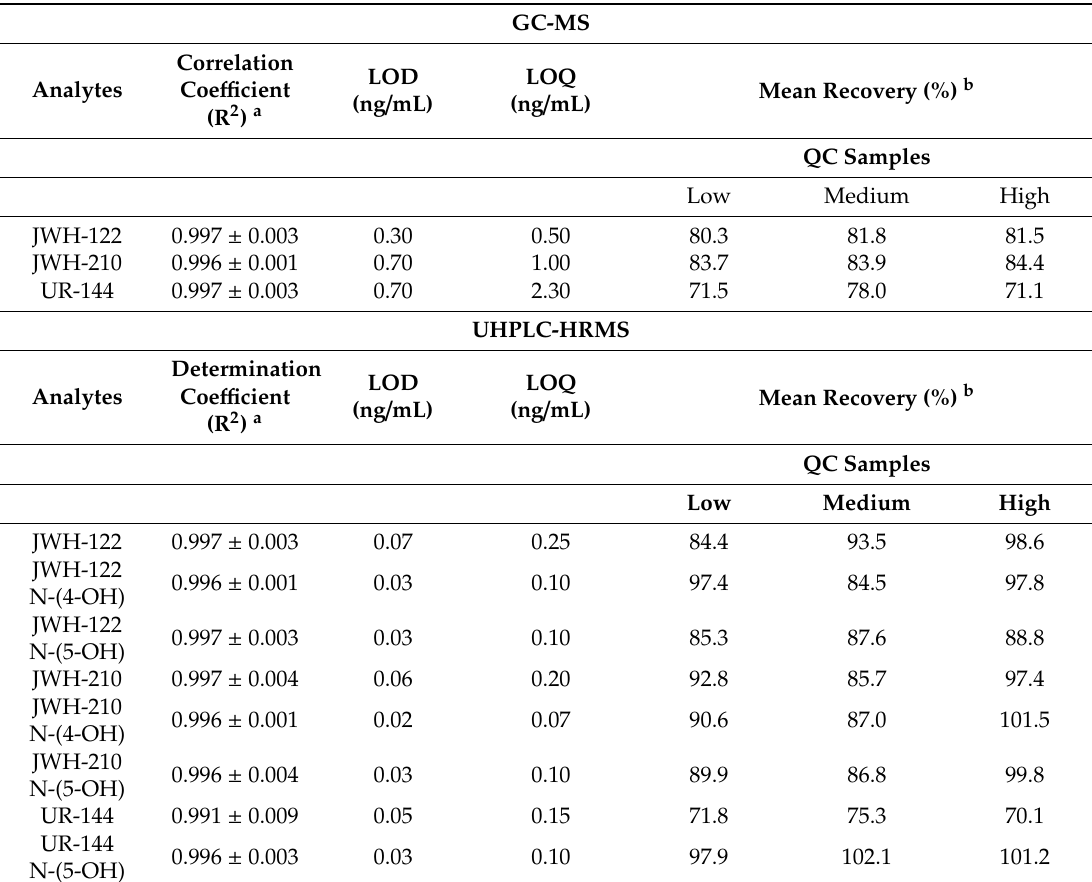
Table 1. Calibration curve parameters, LODs, LOQs and recovery of SCs and their metabolites in OF by GC-MS and